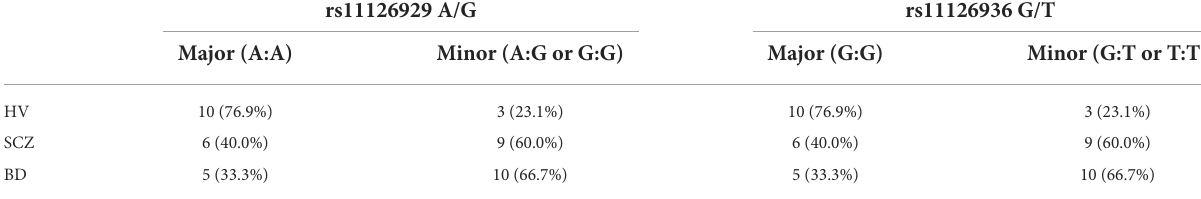
TABLE 3 SLC30A3 genotype for rs11126929 A/G and rs11126936 SNPs by group (HV, healthy volunteers; SCZ, patients with schizophrenia; BD, patients with bipolar affective disorder type